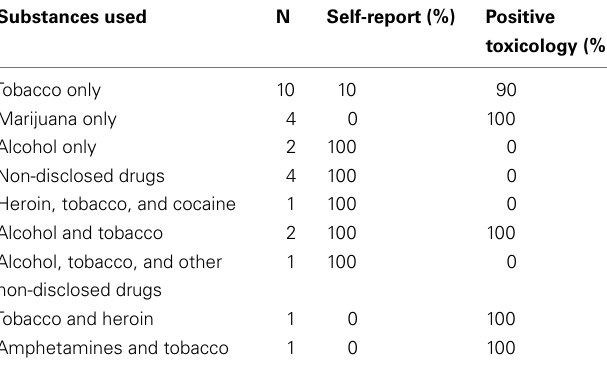
Table 1 | Substance use breakdown including the number of women using particular substances, the percentage who were identified by self-report and the percentage who were identified by urine toxicology on the day of the